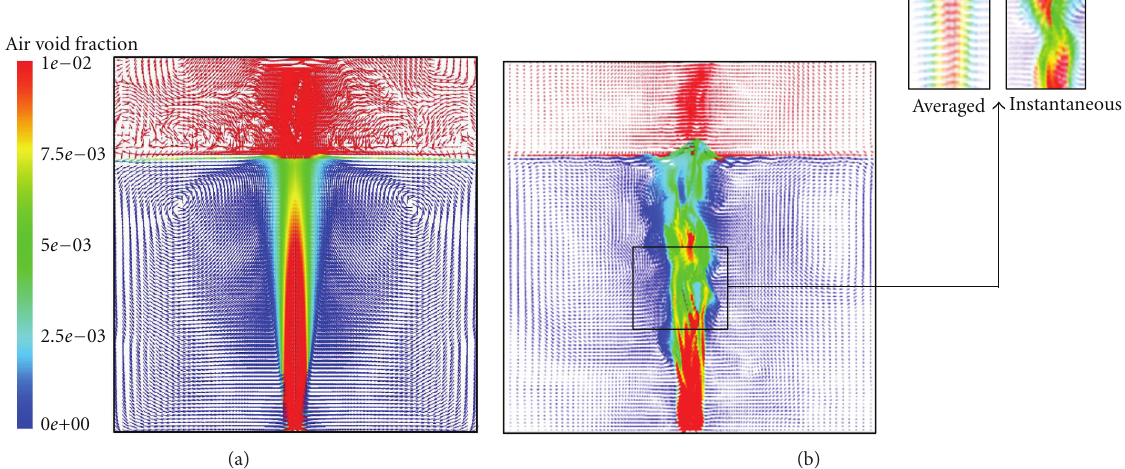
Figure 8: Comparison of k - 𝜖 model and EELES predictions; vector plot of axial velocity coloured with the void fraction in the midplane. (a) k - 𝜖 model (b) EELES (from Dhotre et al.